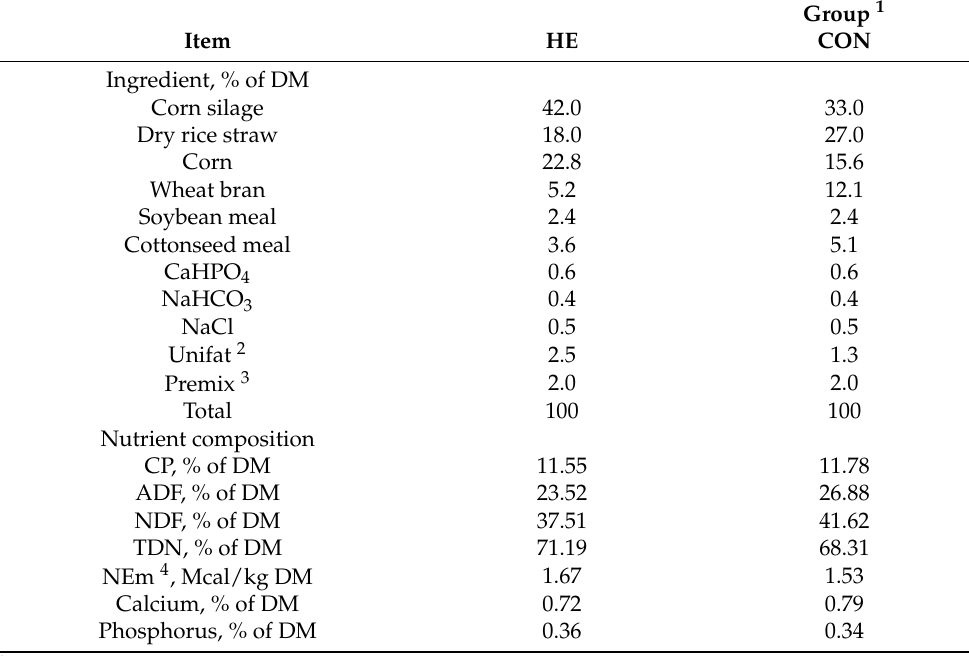
Table 1. Chemical composition of the mixed diets (HE and CON) offered to the cows during the